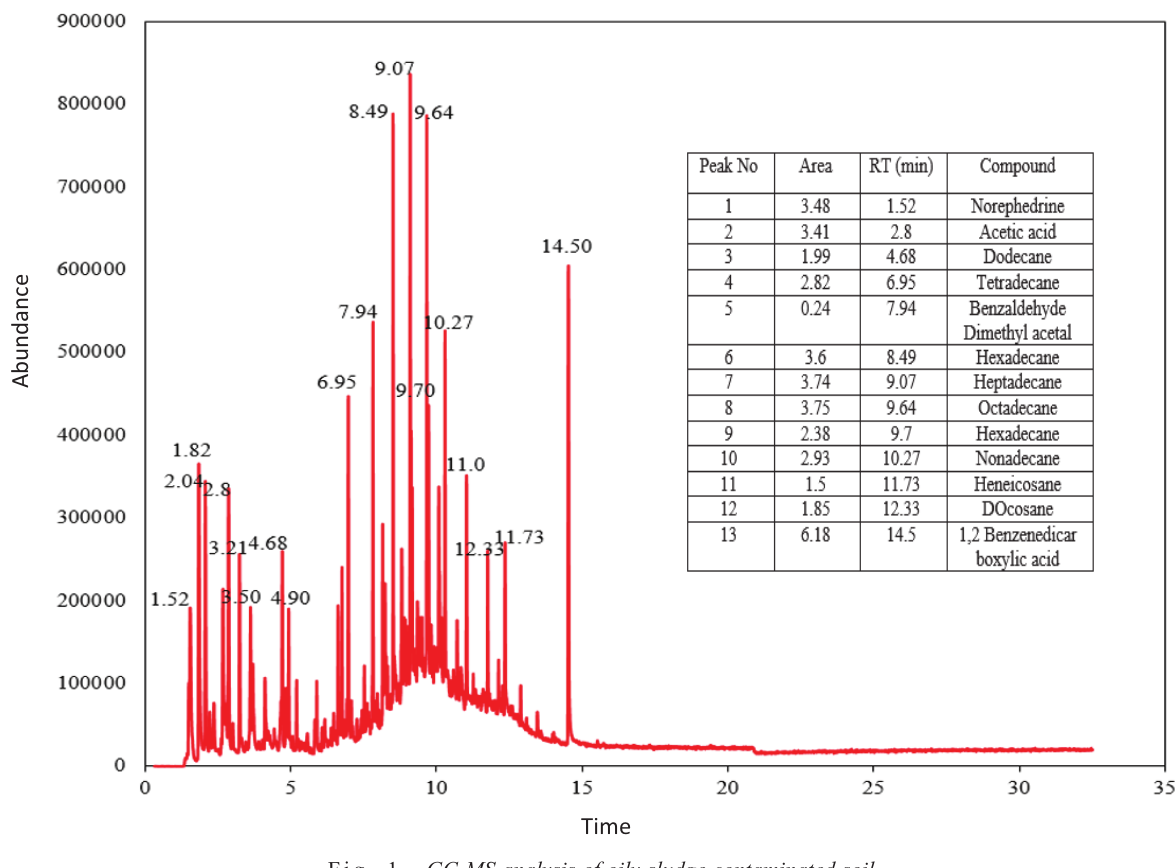
Fig. 1 – GC­MS analysis of oily sludge contaminated soil